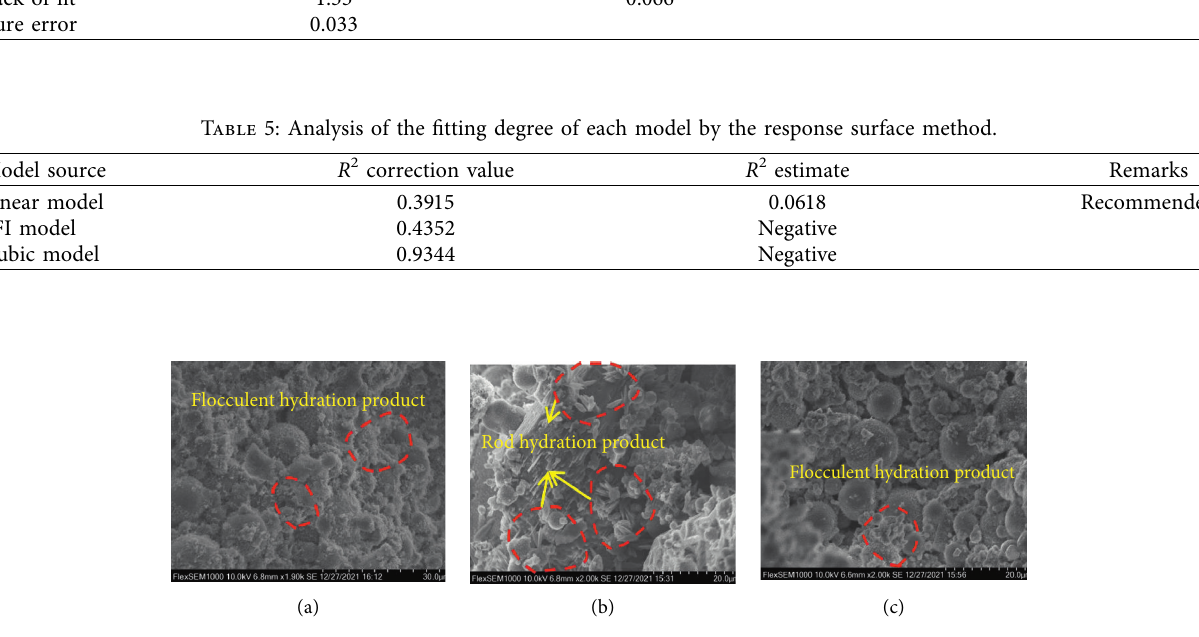
Figure 8: SEM of the typical filling material test block. (a) SEM hydration products of No.18 filling material. (b) SEM hydration products of No. 4 filling material. (c) SEM hydration products of No. 20 filling material.